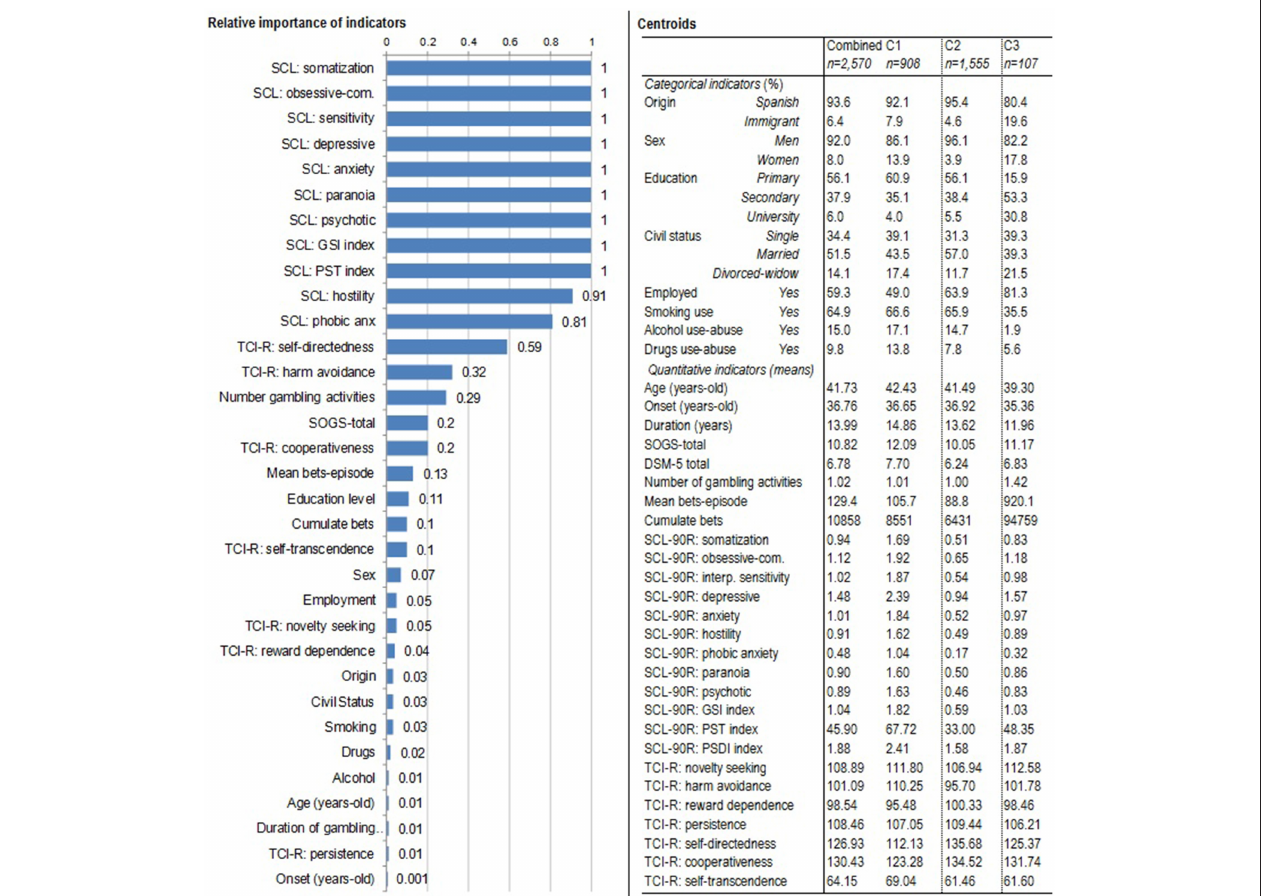
Frontiers in Psychiatry | www.frontiersin.org